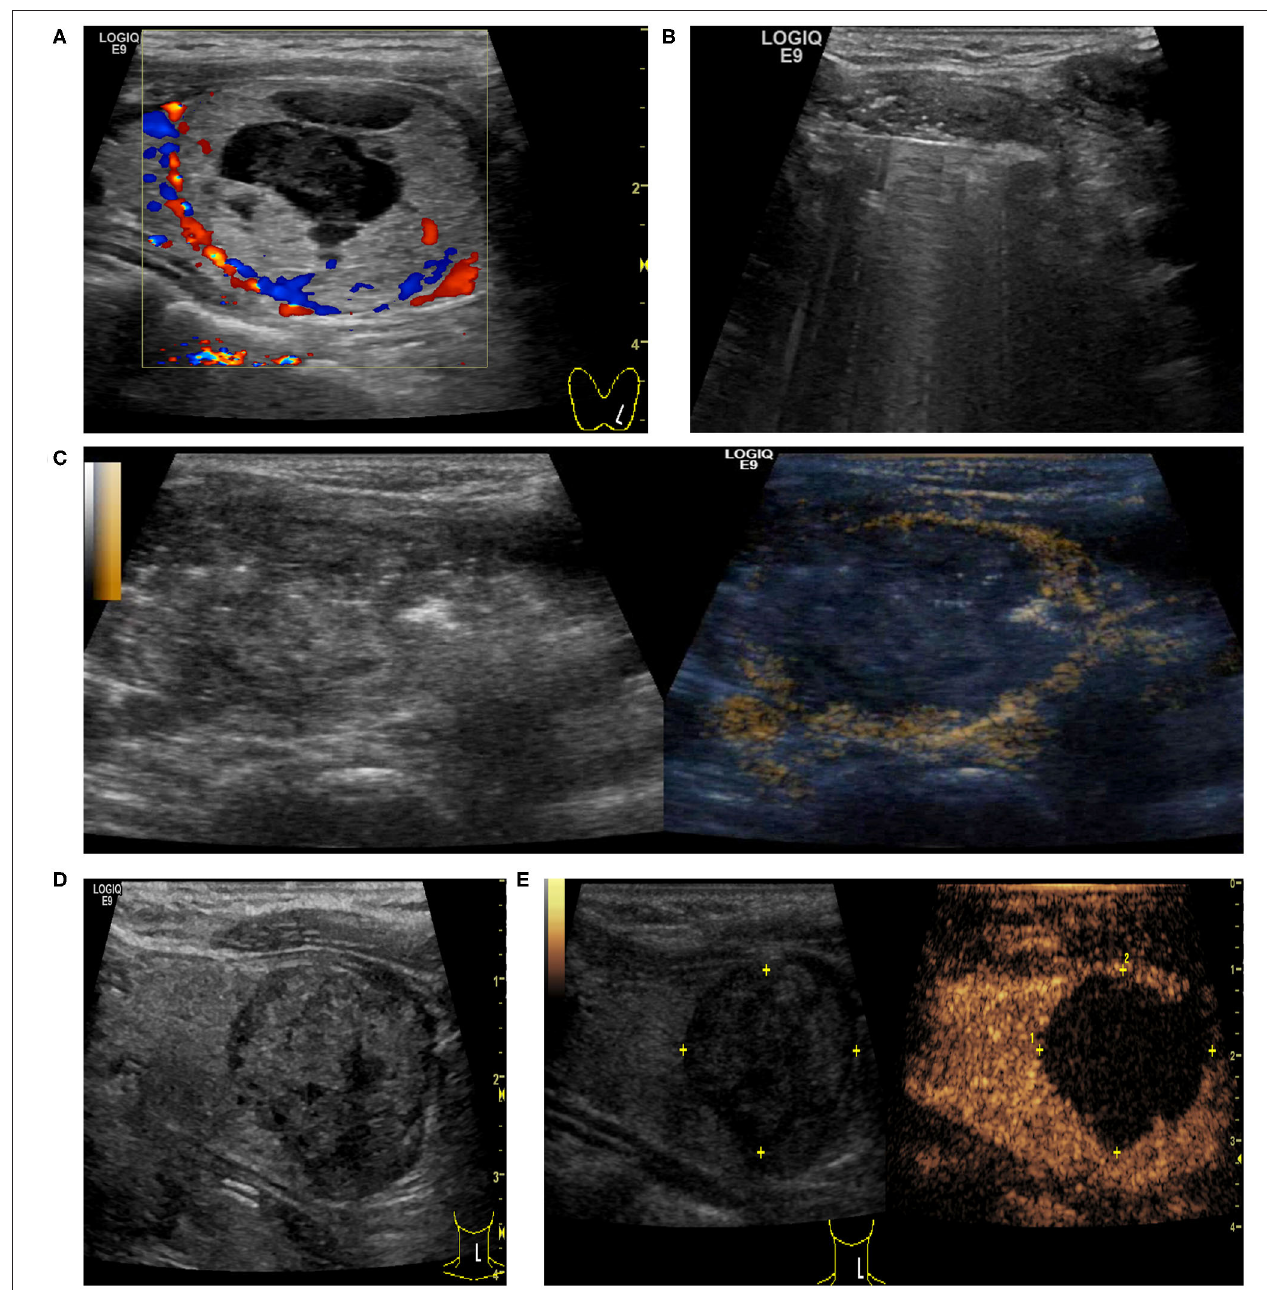
FIGURE 5 | A 38-year-old female had a predominantly solid nodule in the left lobe of the thyroid with a cosmetic score of 4. (A) US examination showed that the baseline volume of the nodule was 26.48ml with the largest nodule diameter of 4.3cm, and CDU showed nodule vascularity was defined as type 1. (B) Ultrasonically guided RFA of thyroid nodule was performed. (C) CEUS after initial RFA: some tissue showed enhancement within the nodule, indicating residual tissue. CEUS-guided additional ablation was carried out to ablate the enhanced areas. (D,E) At 6 months after ablation, US examination showed that the volume of the nodule